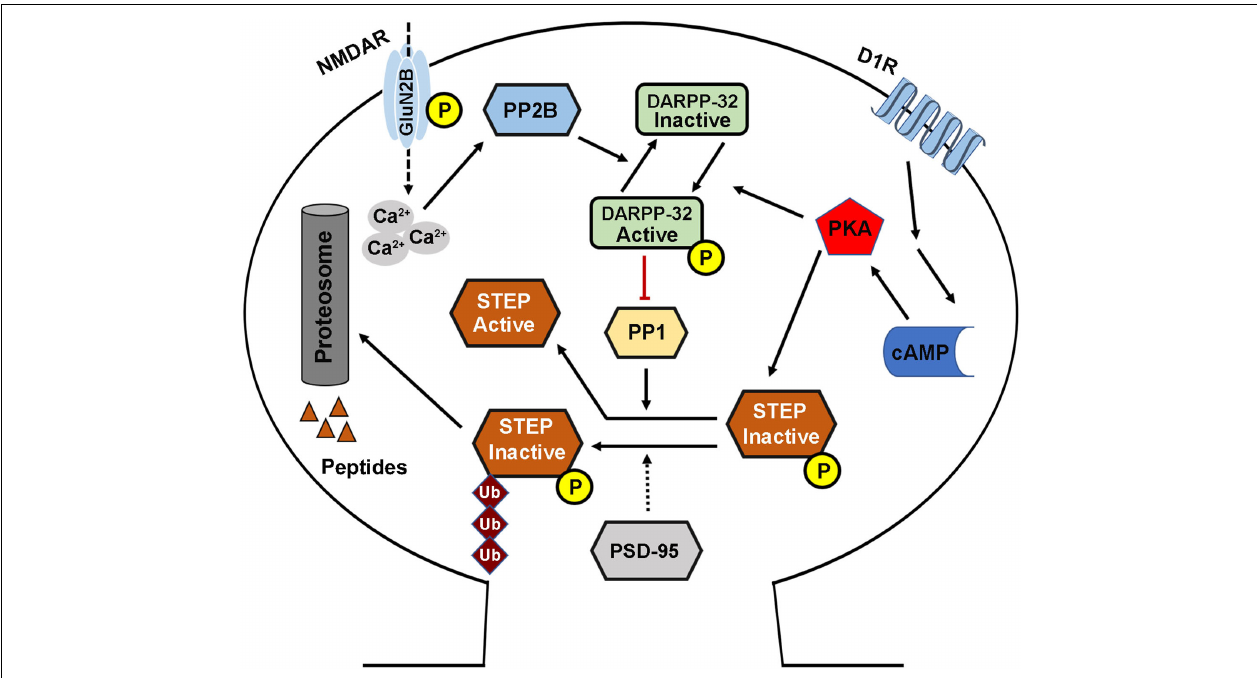
FIGURE 2 | STriatal-enriched protein tyrosine phosphatase activity regulation. The phosphorylation (deactivation) of STEP is mediated by the D1R stimulation of cAMP synthesis that activates PKA. The activated PKA directly phosphorylates STEP in the KIM domain, and this inhibits the binding of STEP to its substrates. PKA can also indirectly mediate the phosphorylation of STEP via the phosphorylation and activation of DARPP-32, an inhibitor of PP1. This leads to the inhibition of PP1 activity, the STEP phosphatase, thereby increasing the phosphorylation of STEP. Phosphorylation of STEP downregulates its ability to bind and dephosphorylate its substrates. On the other hand, the dephosphorylation (activation) of STEP is mediated via NMDAR, and in other condition via α 7nAChR, activation that induce intracellular calcium influx and activation of PP2B. The activated PP2B dephosphorylates and inactivates DARPP-32, thereby removing its inhibitory effect, leading to the activation of PP1 and thus increasing STEP dephosphorylation and activation. STEP level and thus activity could also be regulated via ubiquitination and proteasomal degradation which are mediated by synaptic activation of NMDARs, and could be enhanced by